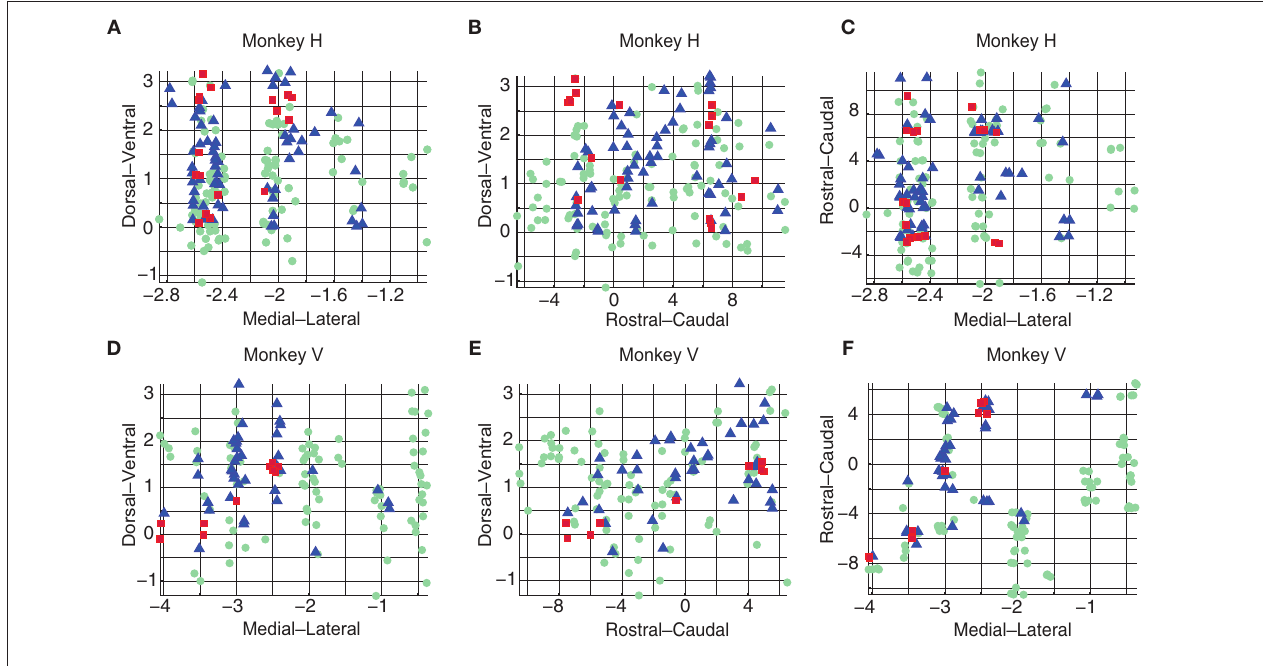
exhibited non-uniform distributions: points of cluster 1 appeared in two patches, one in a rostral and one in a caudal location. Cluster 2 appeared to concentrate on the medial–ventral aspects of the 3D volume. The spatial organization of points belonging to different clusters was similar for the two monkeys.